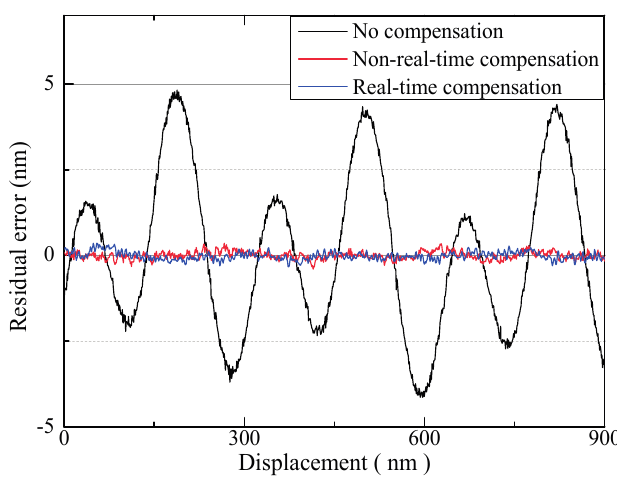
Figure 13. Comparison of the experimentally acquired cyclic